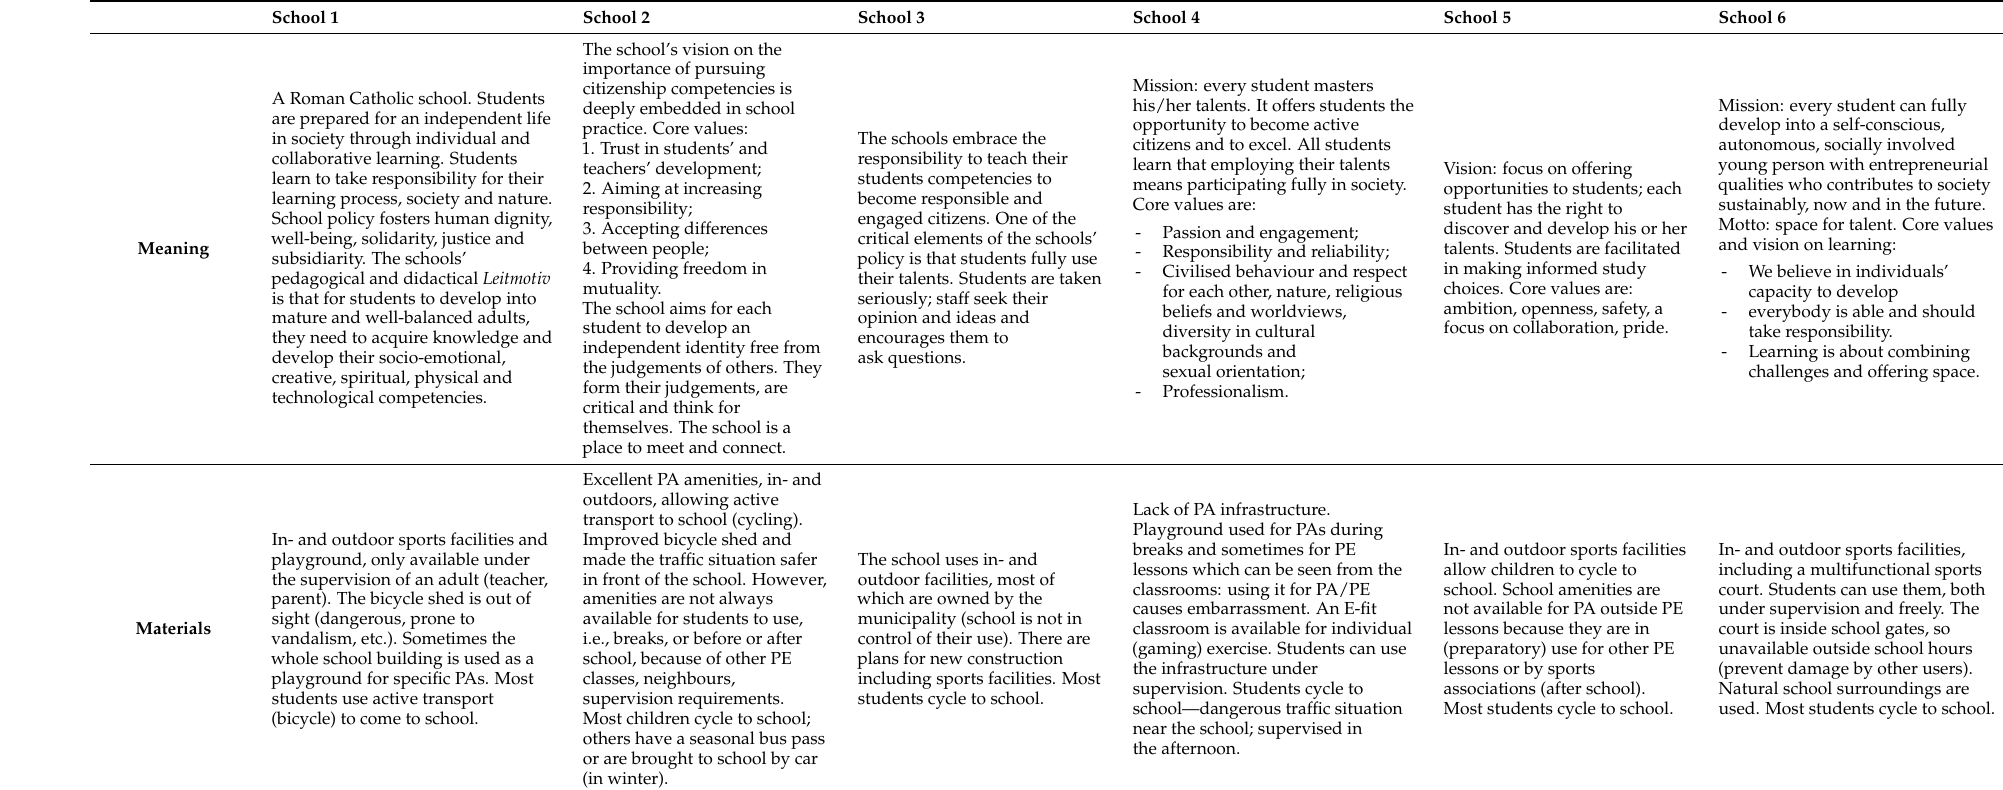
Table 2. School characteristics as social